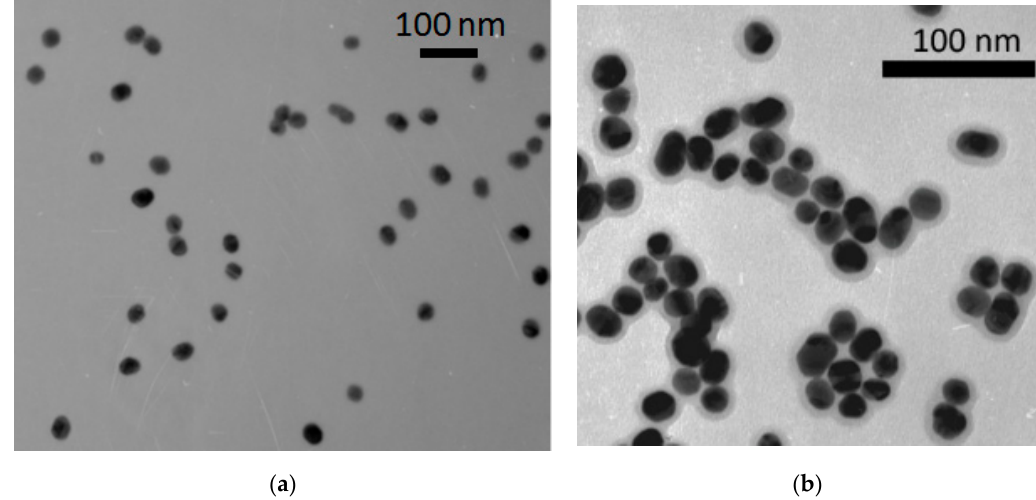
Figure 2. Transmission electron microscopy (TEM) images of unmodified GNPs ( a ) and PAO-modified GNPs ( b ).